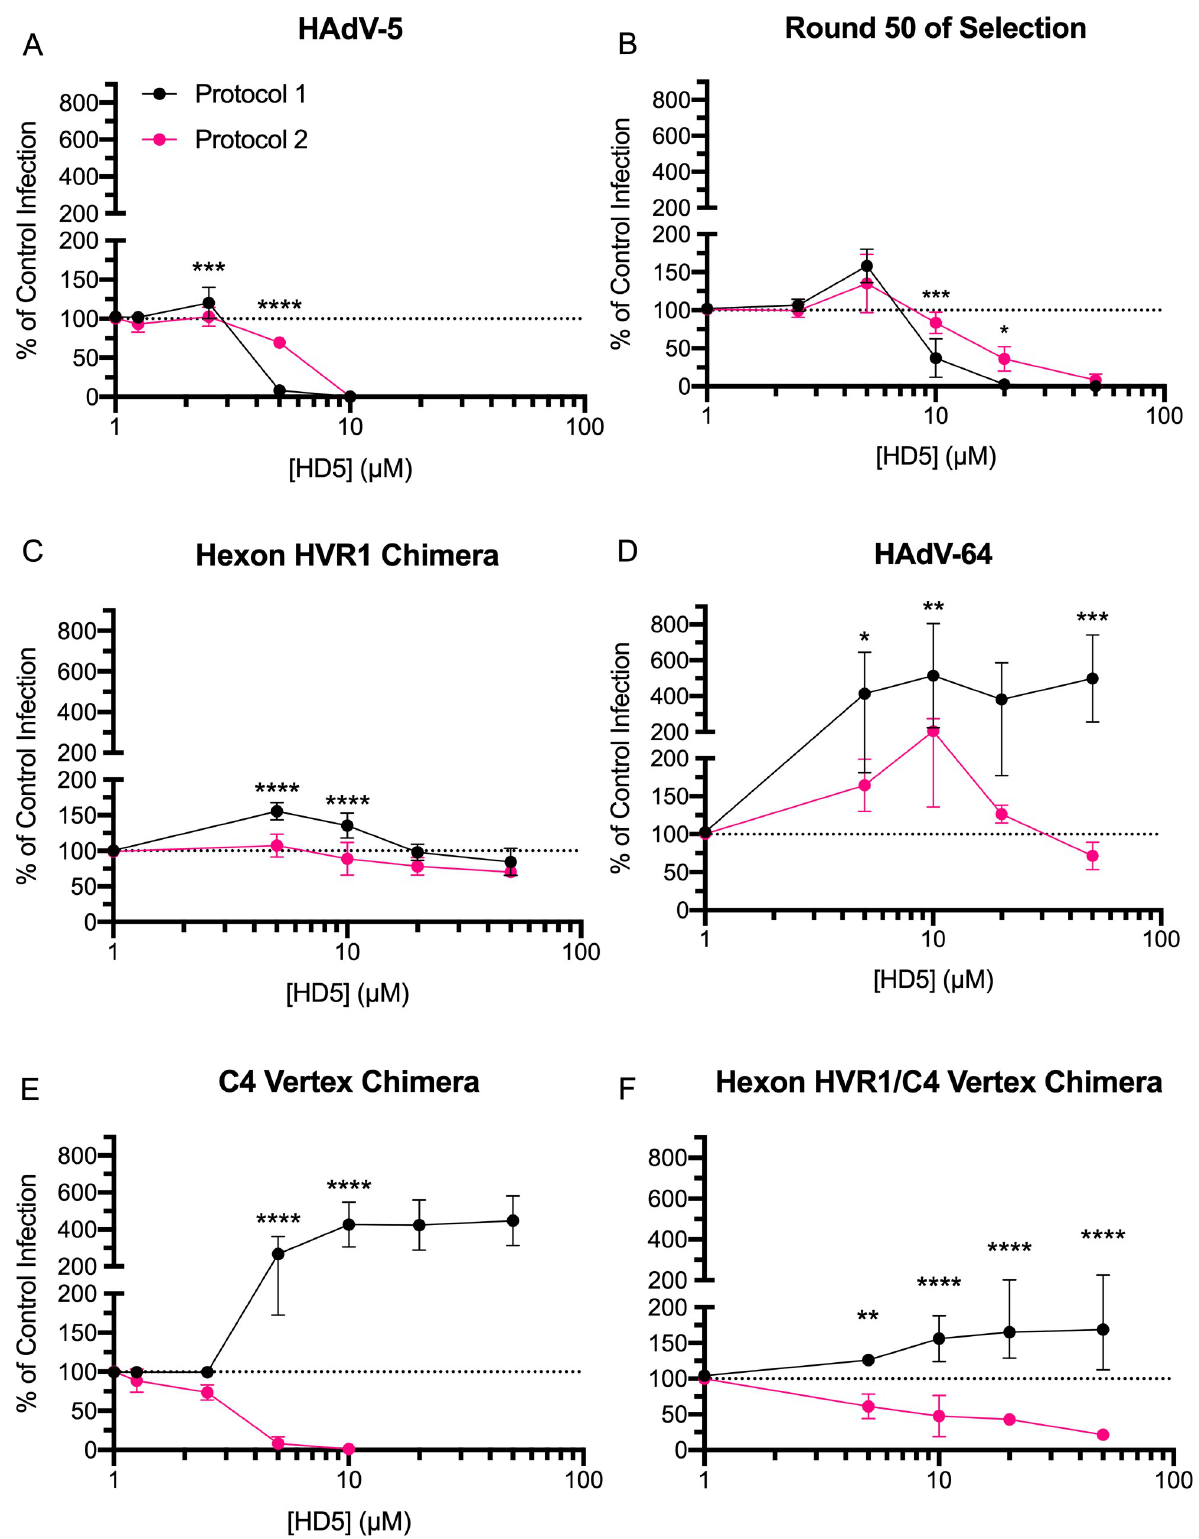
Fig 4. Hexon and vertex play different roles during virus-defensin interactions. Purified (A) HAdV-5, (B) virus expanded from round 50 of selection, (C) hexon HVR1 chimera, (D) HAdV-64, (E) C4 vertex chimera and (F) hexon HVR1/C4 vertex chimera were either incubated with HD5